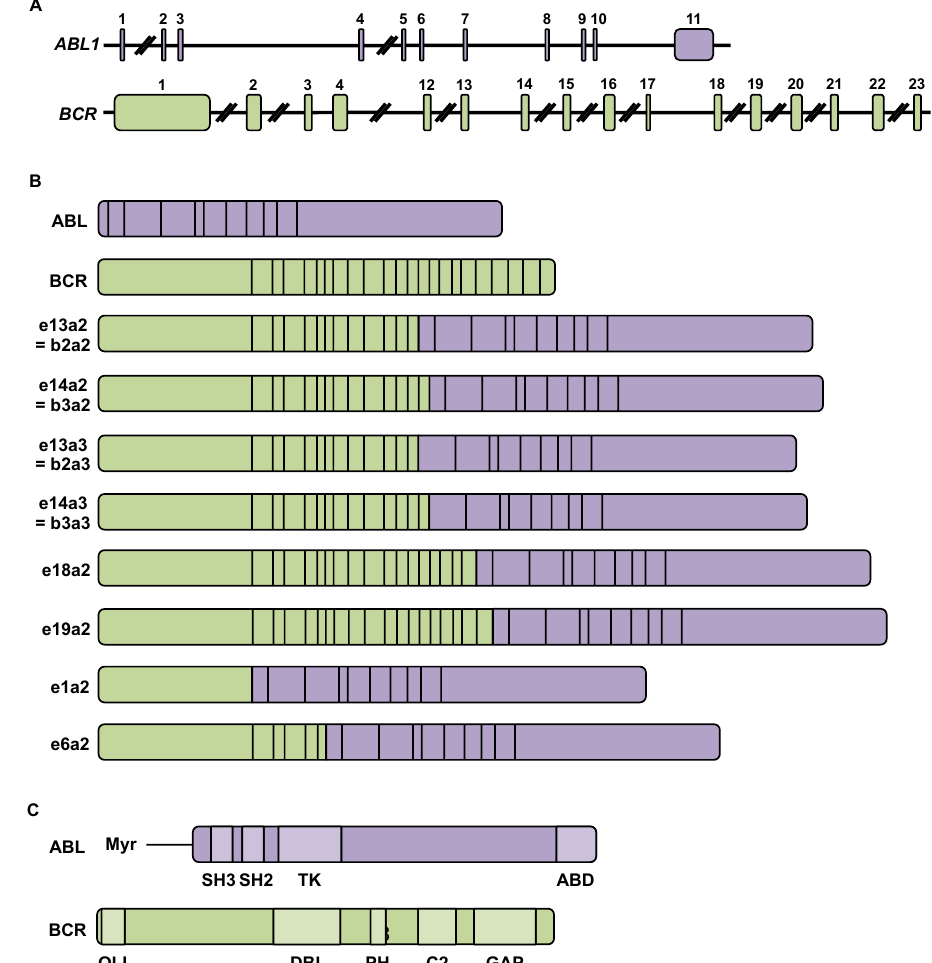
Figure 2. Breakpoints in the Abelson (ABL)1 and breakpoint cluster region (BCR) genes result in the formation of different transcripts encoding the BCR-ABL chimeric protein: ( A ) Structure of the Abelson ( ABL )1 and breakpoint cluster region ( BCR ) genes composed of 11 and 23 exons, respectively; ( B ) Diagram of ABL transcripts (1130 amino acids), BCR (1271 amino acids), and BCR-ABL hybrids. The hybrid mRNA eXaY is produced after cleavage occurs after exon X of BCR and before exon Y of ABL; ( C ) ABL protein (145 kDa) has tyrosine kinase activity and predominantly nuclear localization. It comprises a long lipid chain, myristate (Myr), conferring a capacity for self-inhibition, SH2 and SH3 domains of Src homology, allowing interactions with proline - rich regions and with phosphorylated tyrosines, respectively, a tyrosine kinase (TK) domain, and finally an actin-binding domain (ABD) binding domain to DNA and β - actin. ABL is involved in cytoskeletal dynamics (adhesion, polarity, cell migration, and cellular protrusions), proliferation and cell survival, membrane transport (endocytosis, macropinocytosis, phagocytosis, and caveolae formation) by phosphorylating receptors such as epidermal growth factor receptor, platelet-derived growth factor beta receptor and muscle specific tyrosine kinase receptor [8], and finally in autophagy [9,10]. ABL protein is involved in neurodegenerative diseases and neuroinflammation [9,10]. The BCR protein (160 kDa) has serine/threonine kinase activity and is localized in the cytoplasm [11]. BCR comprises an oligomerization domain (OLI). Mutations in this domain cause a decrease in the tyrosine kinase activity of the BCR - ABL protein and prevent the interaction of BCR and BCR - ABL proteins. It also has a domain of homology to the protein DBL [guanosine diphosphate exchange factor (GDP) in guanosine triphosphate (GTP)], a domain of pleckstrin homology (PH), a C2 domain for binding of calcium - dependent phospholipids, and finally a GTPase (GTPase activating protein) domain (GTPase hydrolysis in GDP and phosphate ion) for binding to Rac proteins.